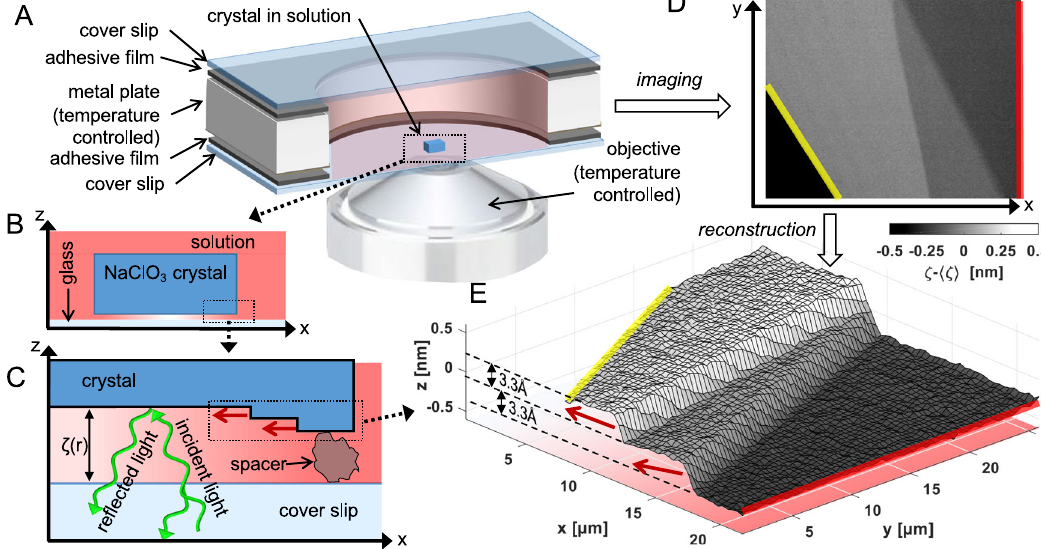
Fig. 1 | Experimental setup. A Sketch of experiment chamber with crystal in solution and high-resolution microscope objective. B Vertical cut of crystal. C Re fl ection of light from crystal and con fi ning surface enables interferometric determination of the distance ζ ( r ) between the crystal and the glass surface and schematicofmolecularstepsoflayeredgrowthfromouteredge. D Interferometric image of partof a growth rim of a crystal surface. E Reconstruction of local crystal